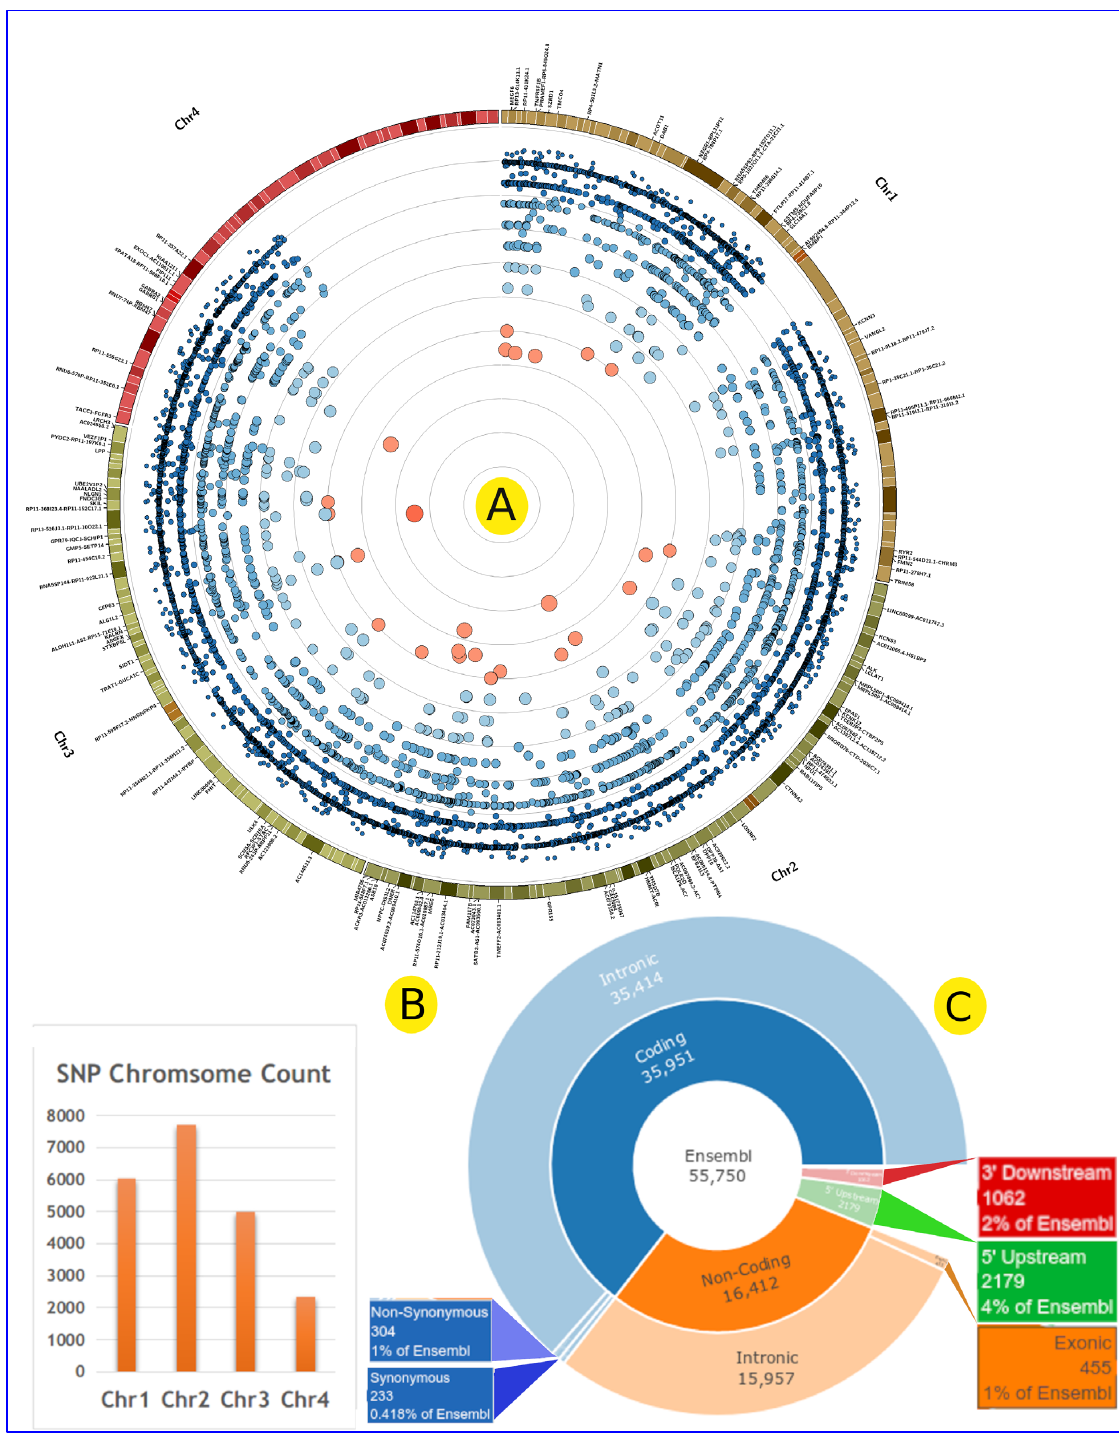
Figure 4. The chromosomal distribution of the identified SNPs and their association scores with EH. The colored small circles represent SNPs’ location on the human genome and their hypertension association score (−log10 of p value) according to the Fisher’s exact test. Blue and small circles represent non-significant SNPs, while large and red circles represent significant SNPs ( A ). The number of SNPs according to human chromosome ( B ). Predicted functional consequences. SNPs are classified into several groups based on their location in and effect on gene structures, which include coding and non-coding regions according to different databases ( C ).